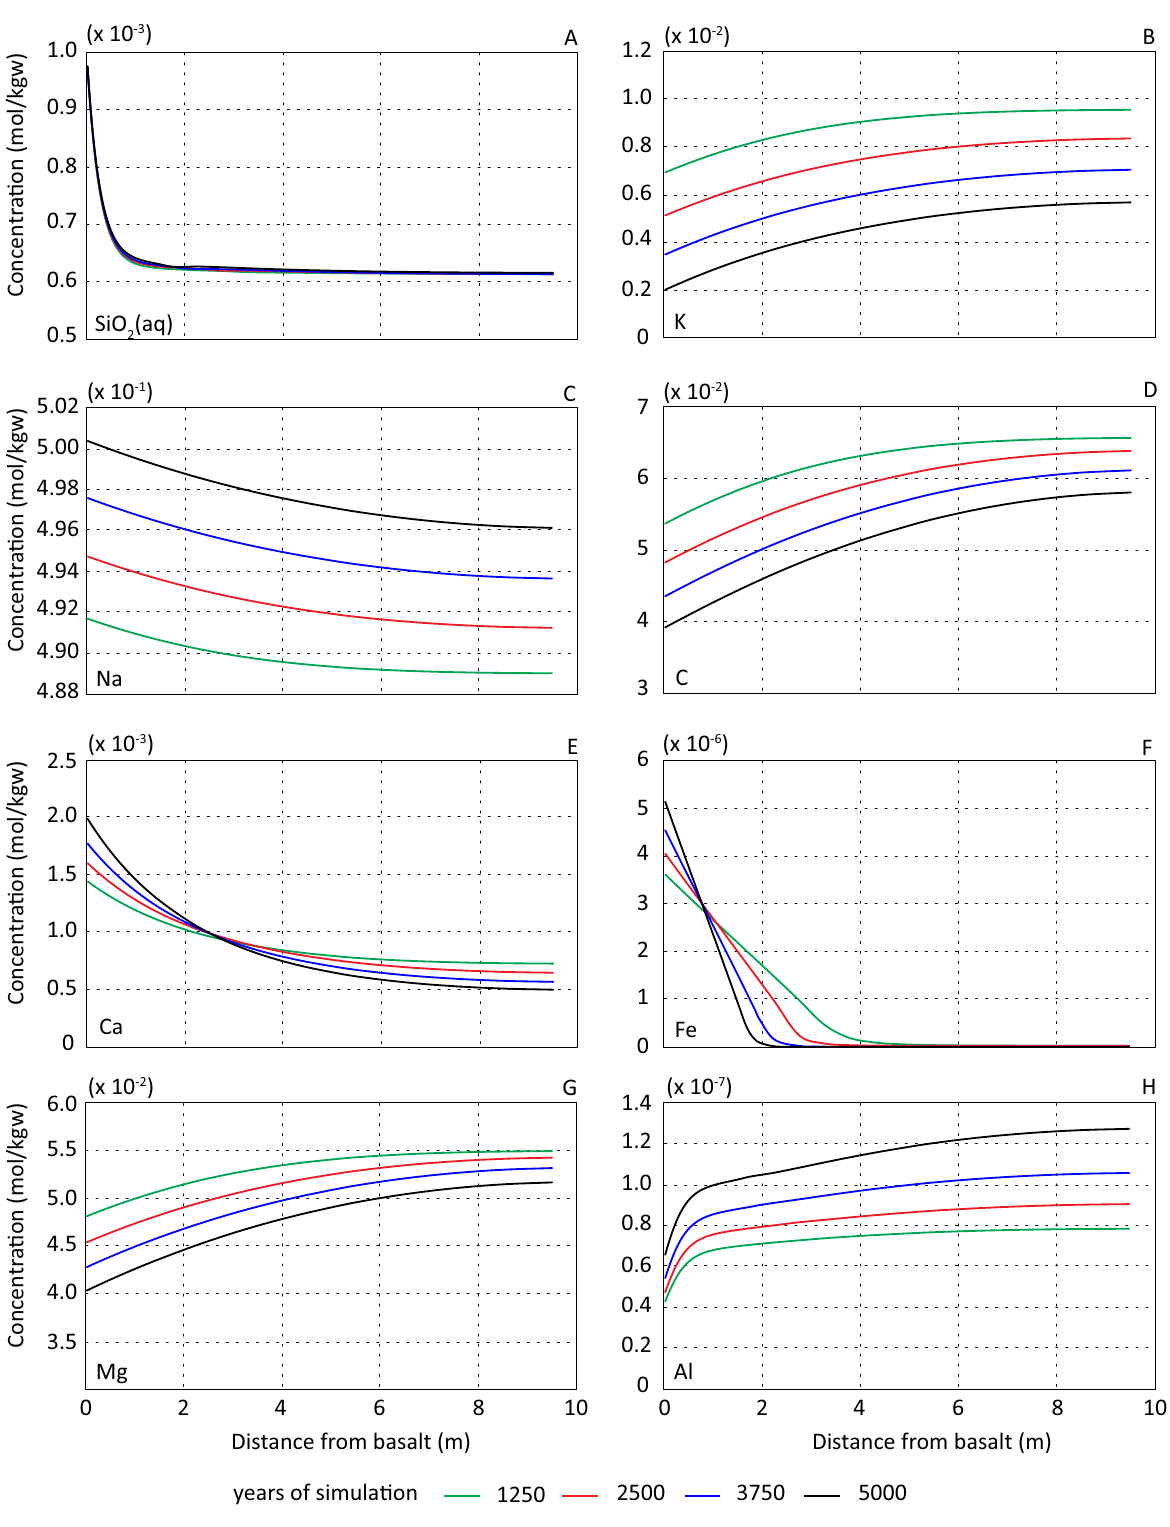
Figure 5. Formation water element concentrations (mol/kgw). Results are displayed for scenario 2 as distance from basalt-sediment interface after 1250, 2500, 3750 and 5000 years of